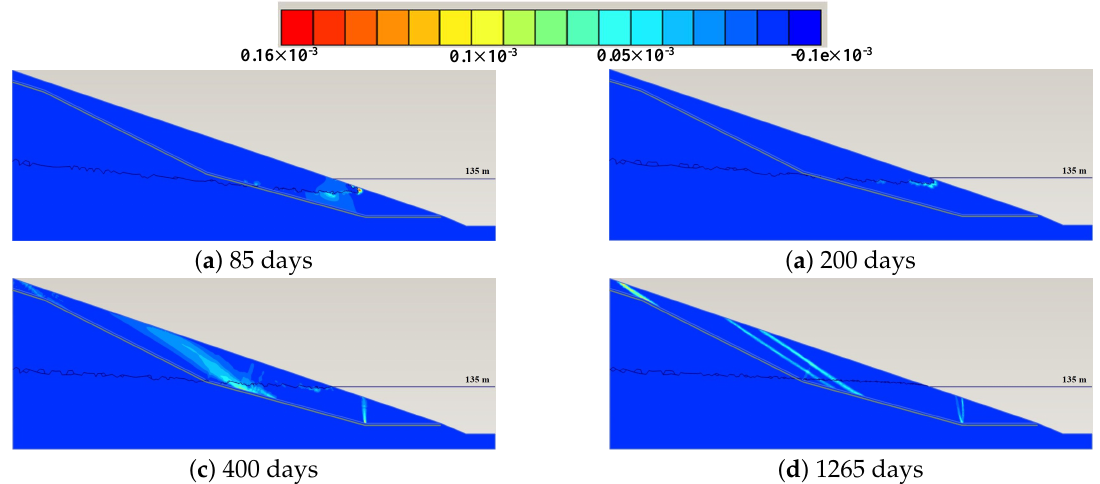
Figure 6. Evolution of the incremental deviatoric strain ∆ γ at different time steps after the river level starts